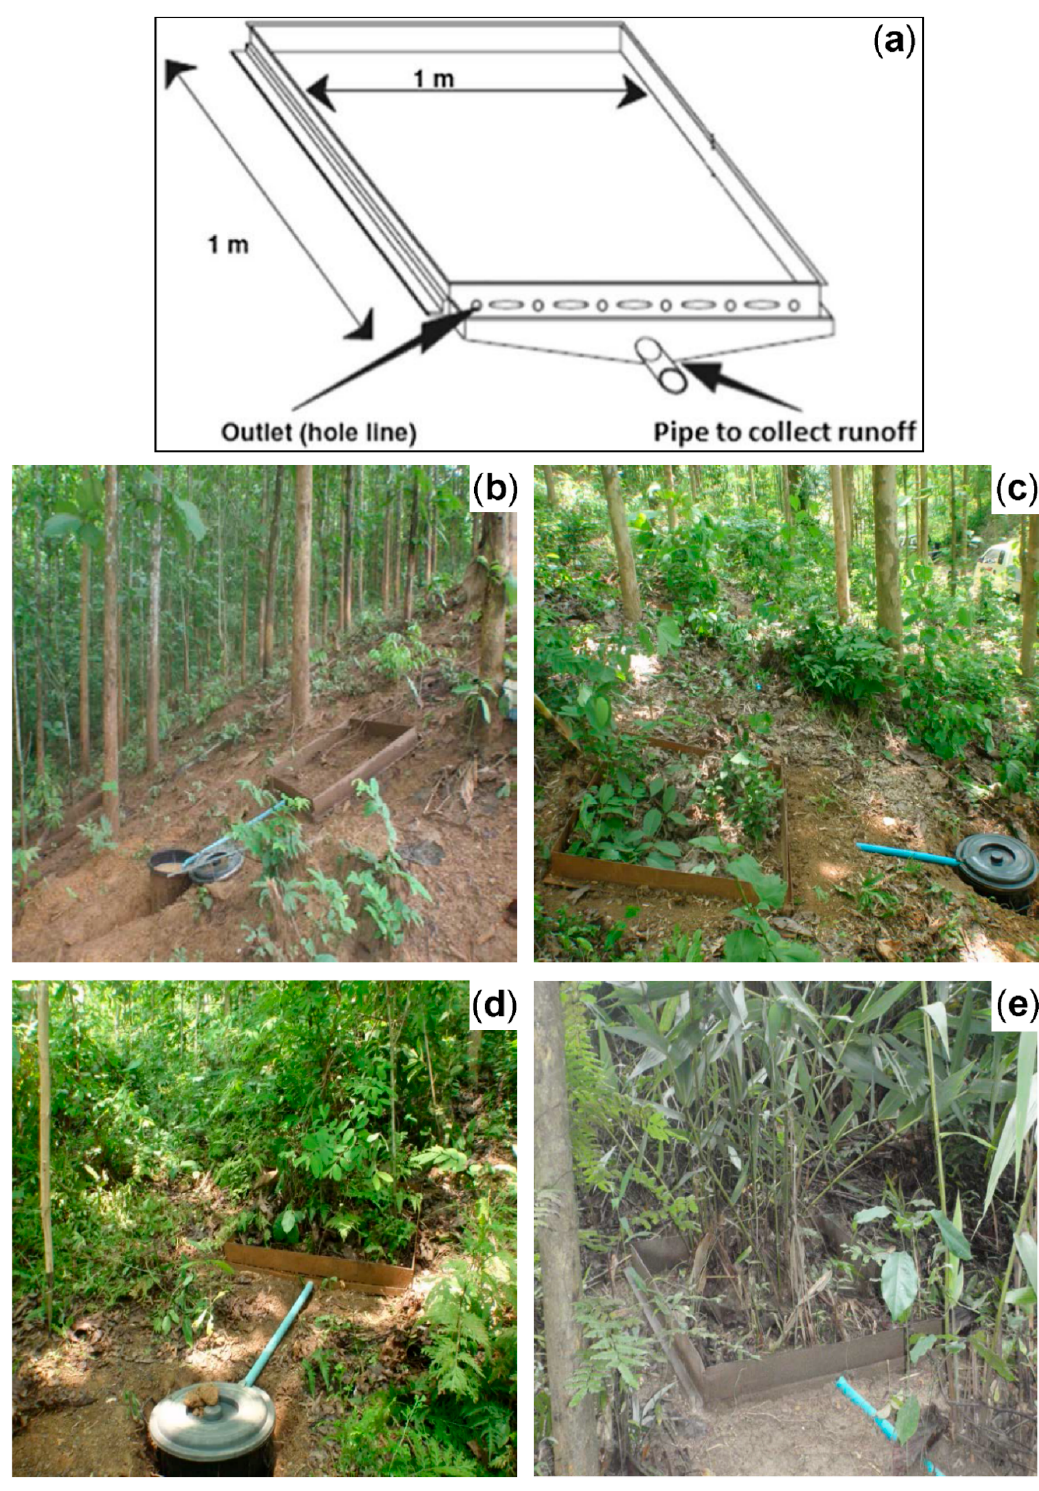
Figure 2. ( a ) Sketch of microplot of 1 × 1 m metal frame connected to a bucket through a pipe for surface runoff and sediment collection (source: [31] ). ( b ) Microplot of TNU: teak with no understory. ( c ) Microplot of TLU: teak with low density of understory. ( d ) Microplot of THU: teak with high density of understory. ( e ) Microplot of TBG: teak with broom grass. Microplots were installed on 9th and 10th of May 2017, in Ban Kokngew, Luang Prabang Province, Lao People’s Democratic Republic.